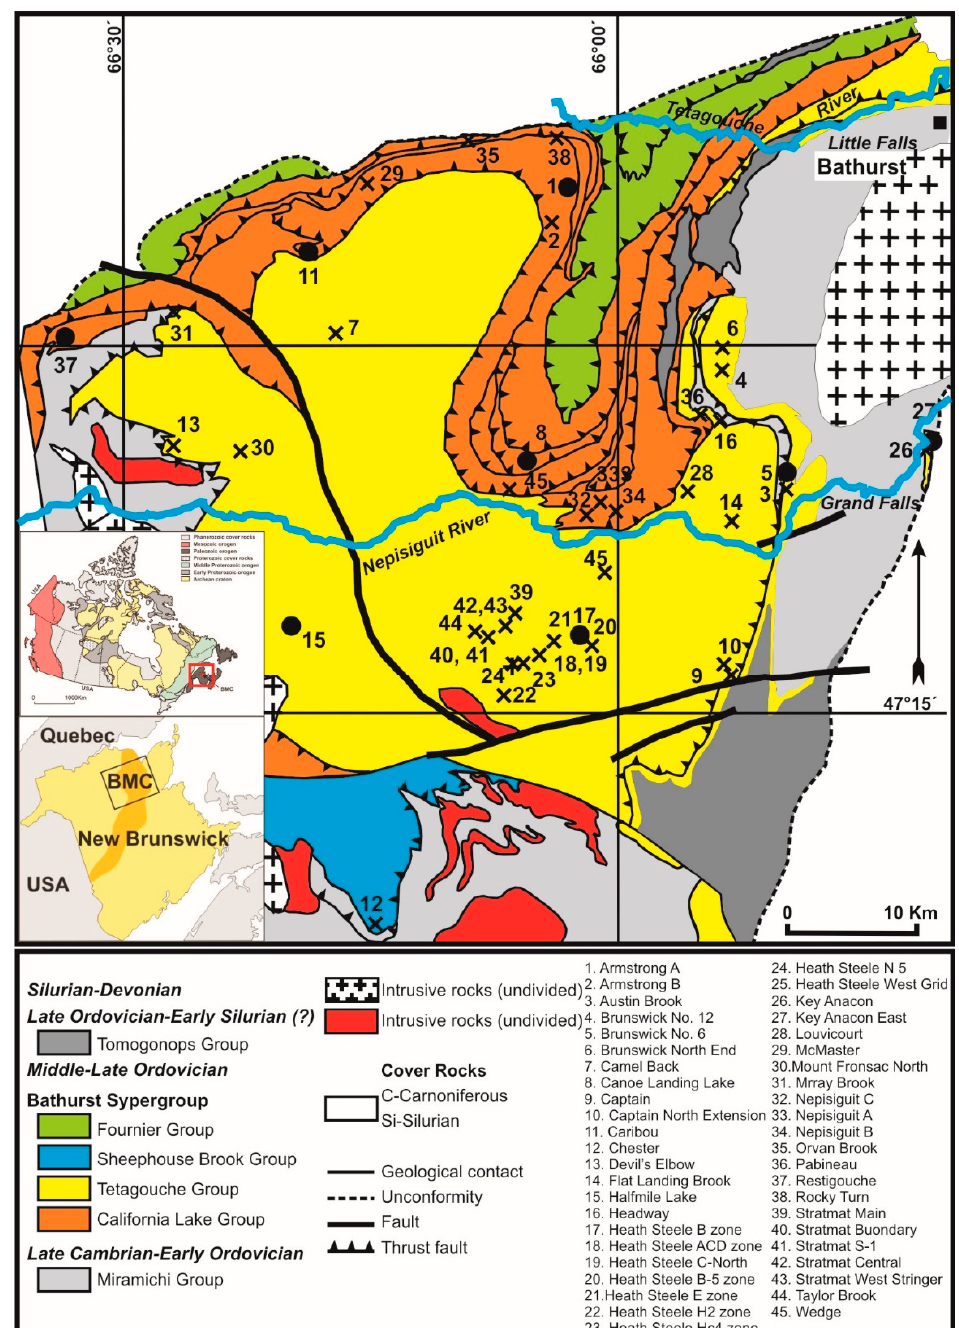
Figure 1. Simplified geological map of the Bathurst Mining Camp, northeastern New Brunswick, showing the location of massive sulphide deposits examined during this study (black circles) (modified from [26,29]).